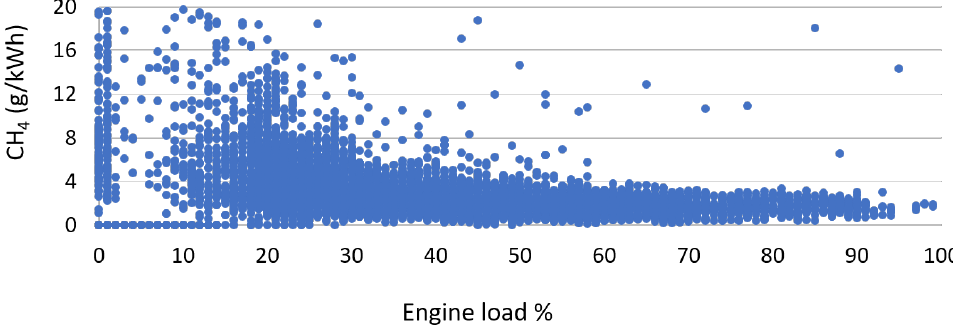
Figure 5. Specific CH 4 emissions as a function of engine load%.